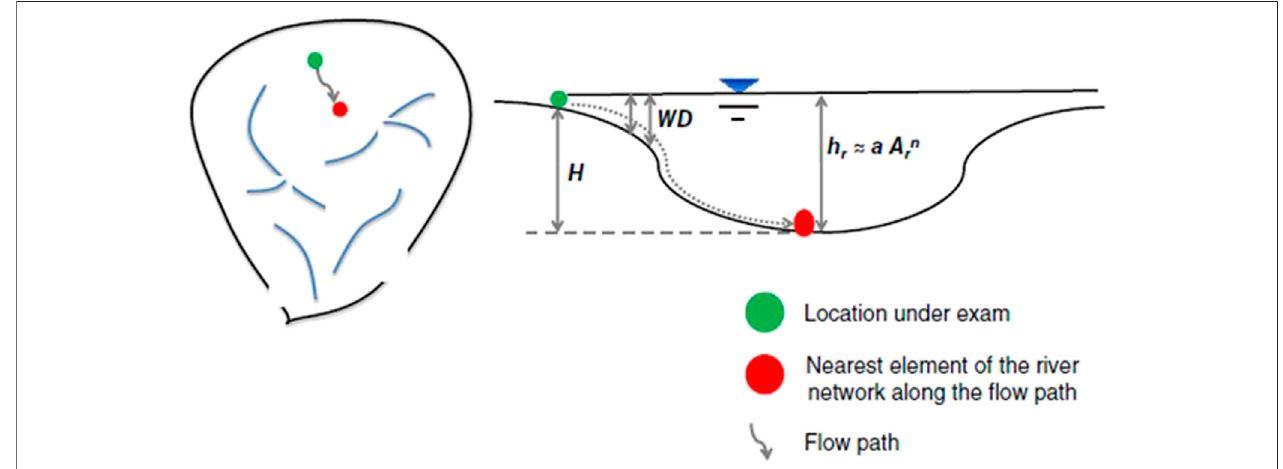
FIGURE 2 | A basin cross-section and its parameters to calculate the geomorphic GFI and the inundation depth (Source: Manfreda et al., 2019).